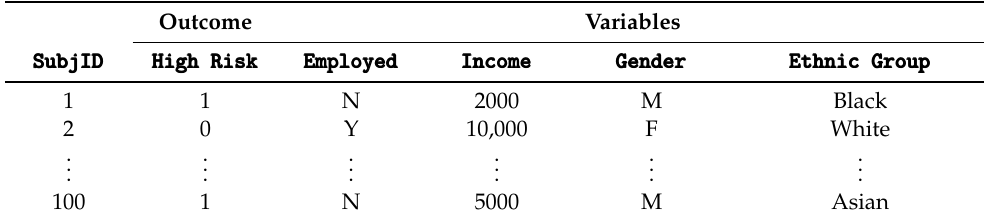
Table 1. Example decisional process of a financial